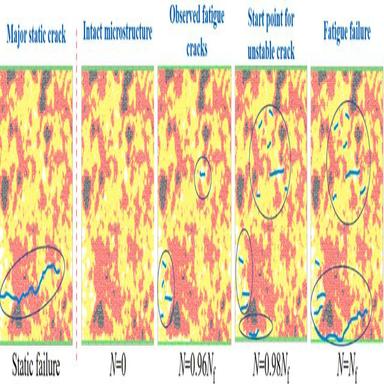
Simulated fatigue fracture behaviours of cement pastes (w/c 0.4) under the the stress level of 50 %, adapted from .